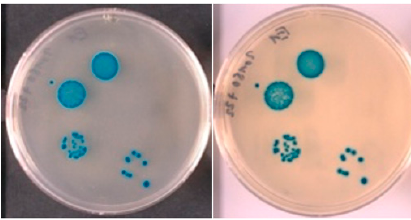
Scheme 3. Indigo dye formation using indoxyl substrate X-Gal.